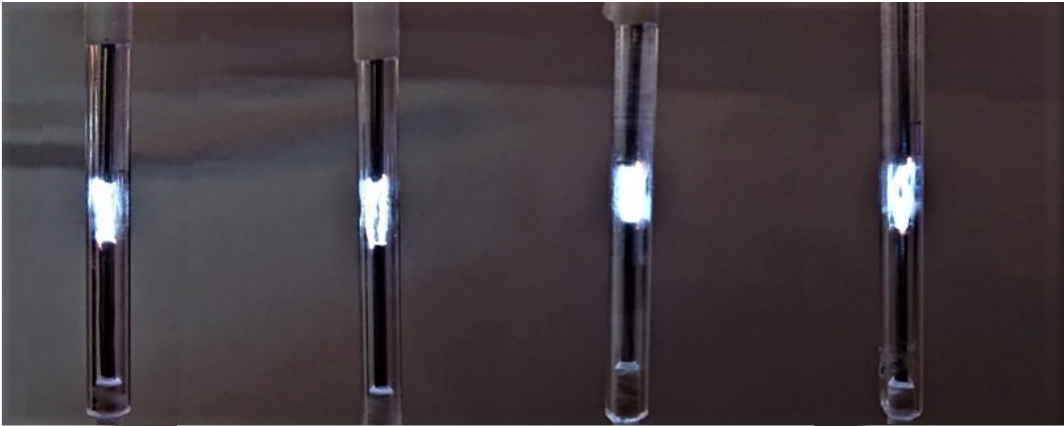
Figure 11. Four discharges working in parallel for CCL type of NTP mini-reactor.